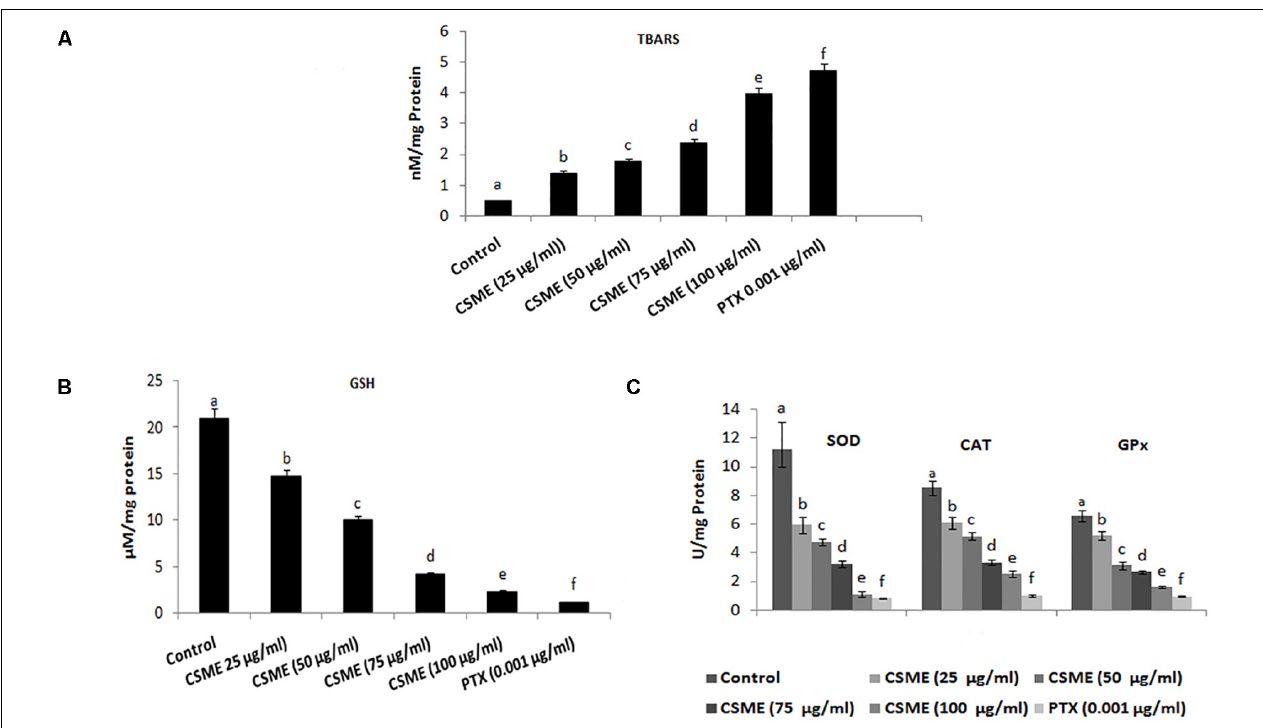
FIGURE 4 | CSME treatment modulates lipid peroxidation and antioxidant status in MDA-MB-231 cells. MDA-MB-231 cells were treated with different concentrations of CSME for 24 h. Cells were collected and lipid peroxidation was assessed by measuring the levels of (A) TBARS and (B) GSH levels; (C) SOD, CAT, and GPx enzymatic activities. Values are given as mean ± SD of six experiments in each group. Values not sharing a common marking (a, b, c, d, e, and f) differ significantly at P < 0.05 versus control